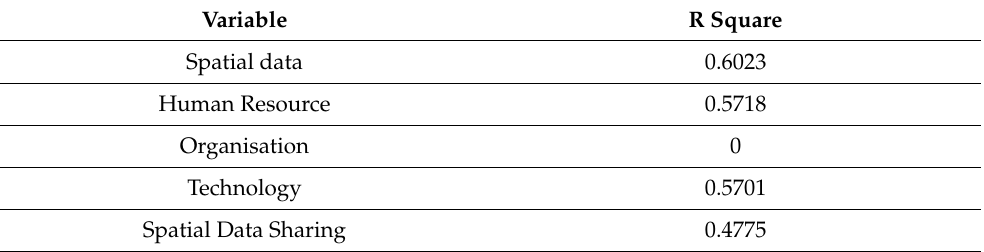
Table 9. R-square